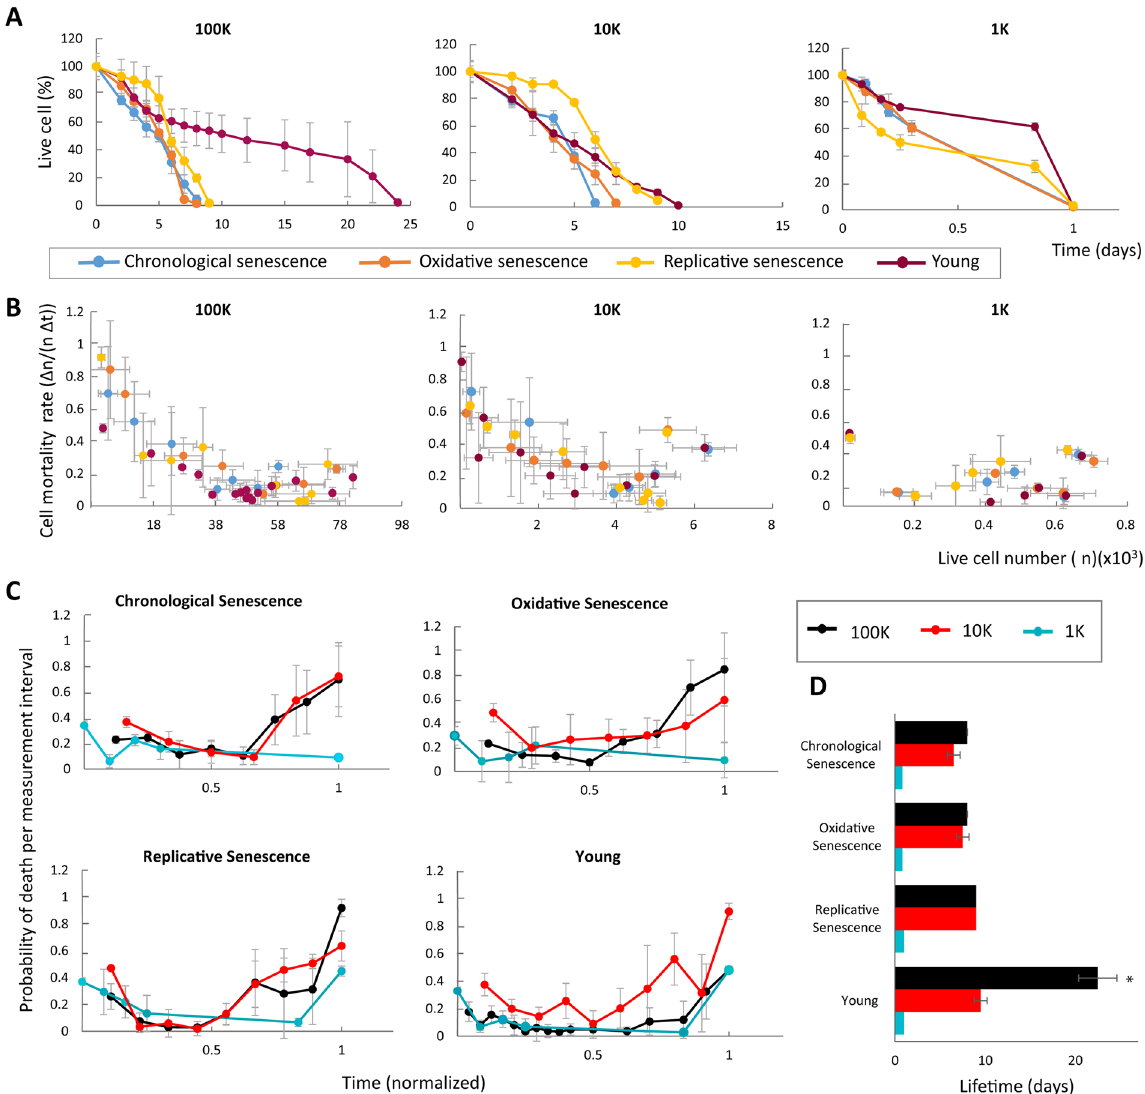
Figure 2. Failure characteristics of synthetic tissues made from young or pre-aged cells. The change of ( A ) live cell percentage over time, ( B ) cell mortality rate with respect to live cell number, and ( C ) probability of death over time. ( D ) The lifetime of synthetic tissues made from young or pre-aged cells with different population densities ( * indicates significance, p < 0.05). Denser tissues where cells can interact, display age specific mortality, whereas the mortality rate of sparse tissues is closer to